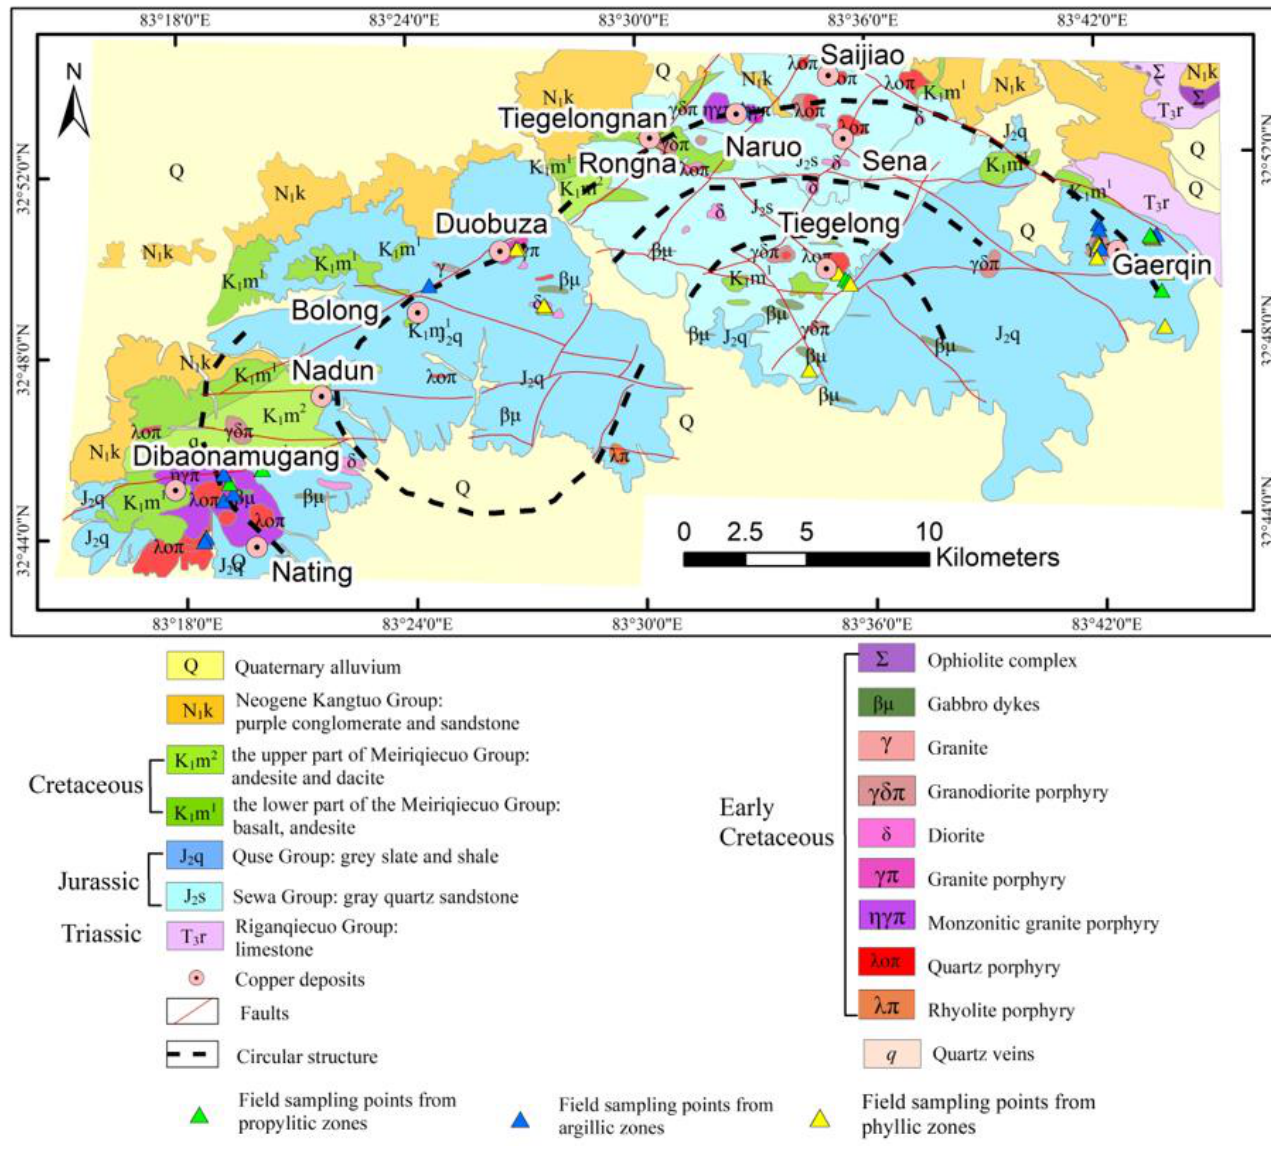
Figure 1. Geological map of the Duolong ore district modified from Ref. [32,33] .